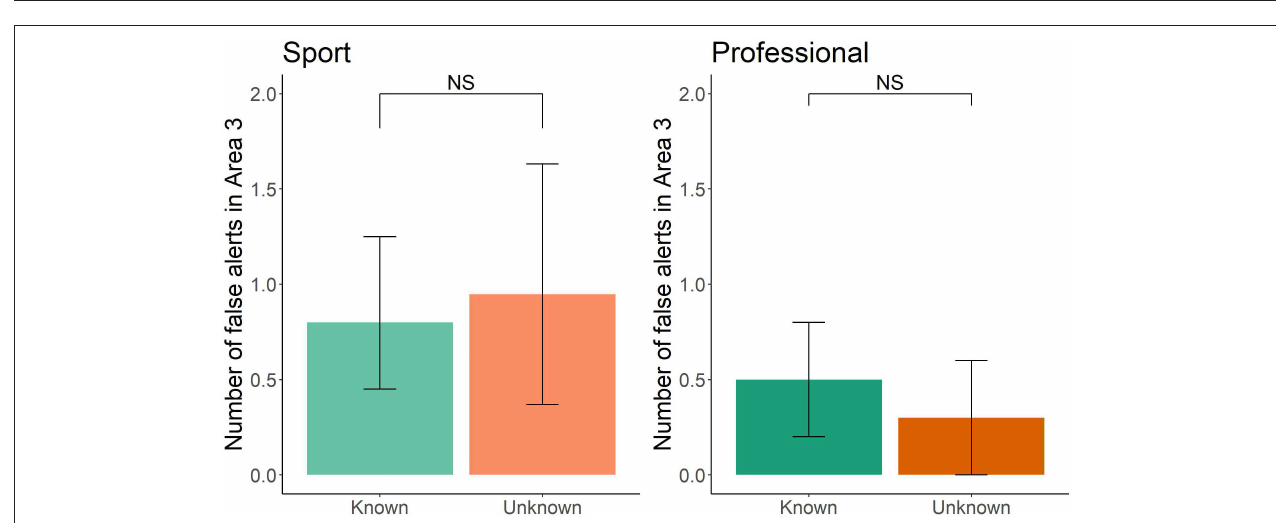
FIGURE 5 | Known vs. Unknown group in sport and professional handler dog teams for number of false alerts in area 3. Error bars represent 95% confidence intervals.